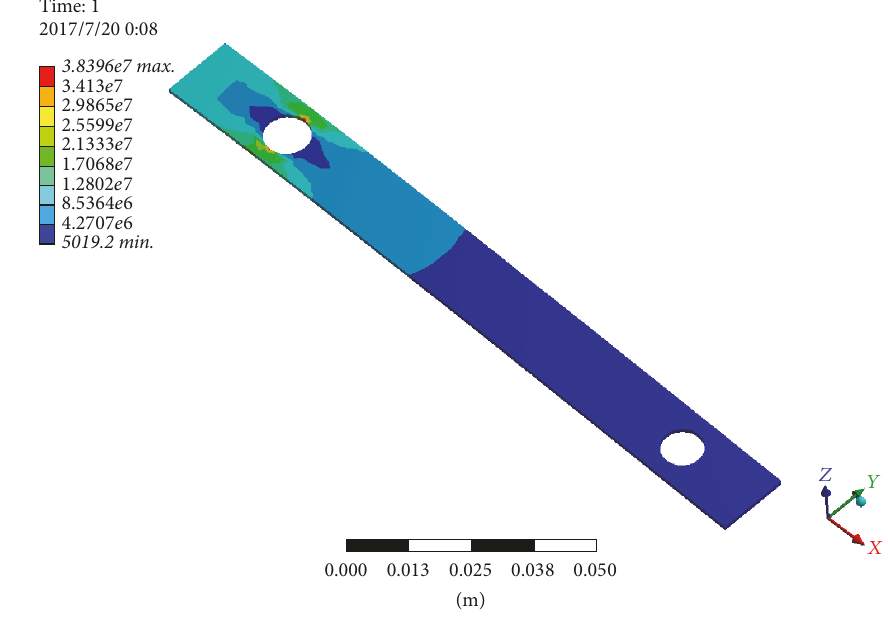
Figure Type: maximum shear stress—top/bottom—layer 0